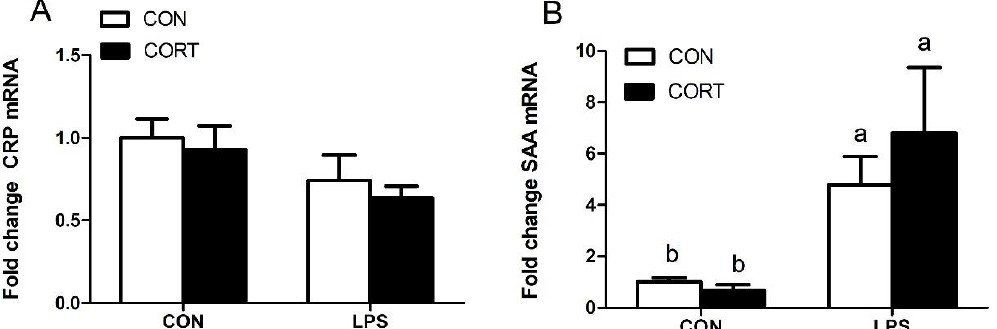
Figure 4. Expression of hepatic genes related to acute-phase proteins. ( A ) Hepatic expression of CRP